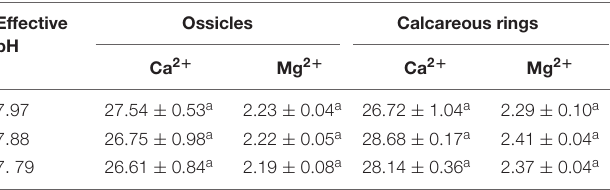
TABLE 2 | Concentrations of Ca 2 + and Mg 2 + in ossicles and calcareous rings in H. forskali collected at week 22 exposed to pH 7.97, 7.88, and 7.79 levels. Effective Ossicles pH